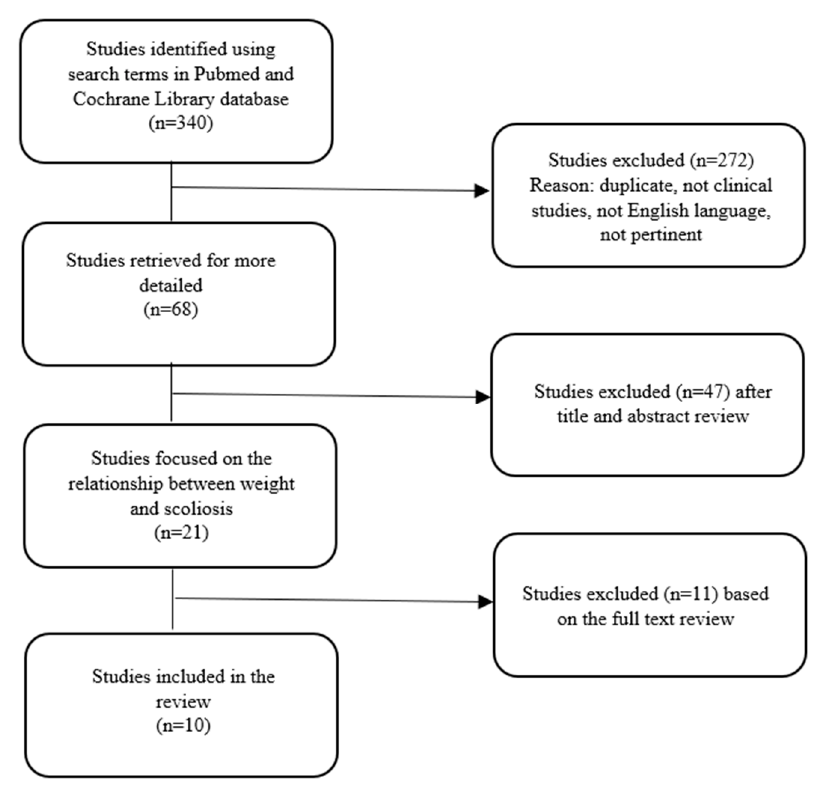
Figure 1. Study Figure 1. Study selection .